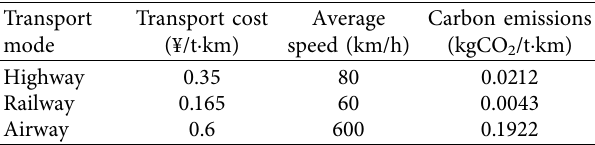
Table 4: Transport mode